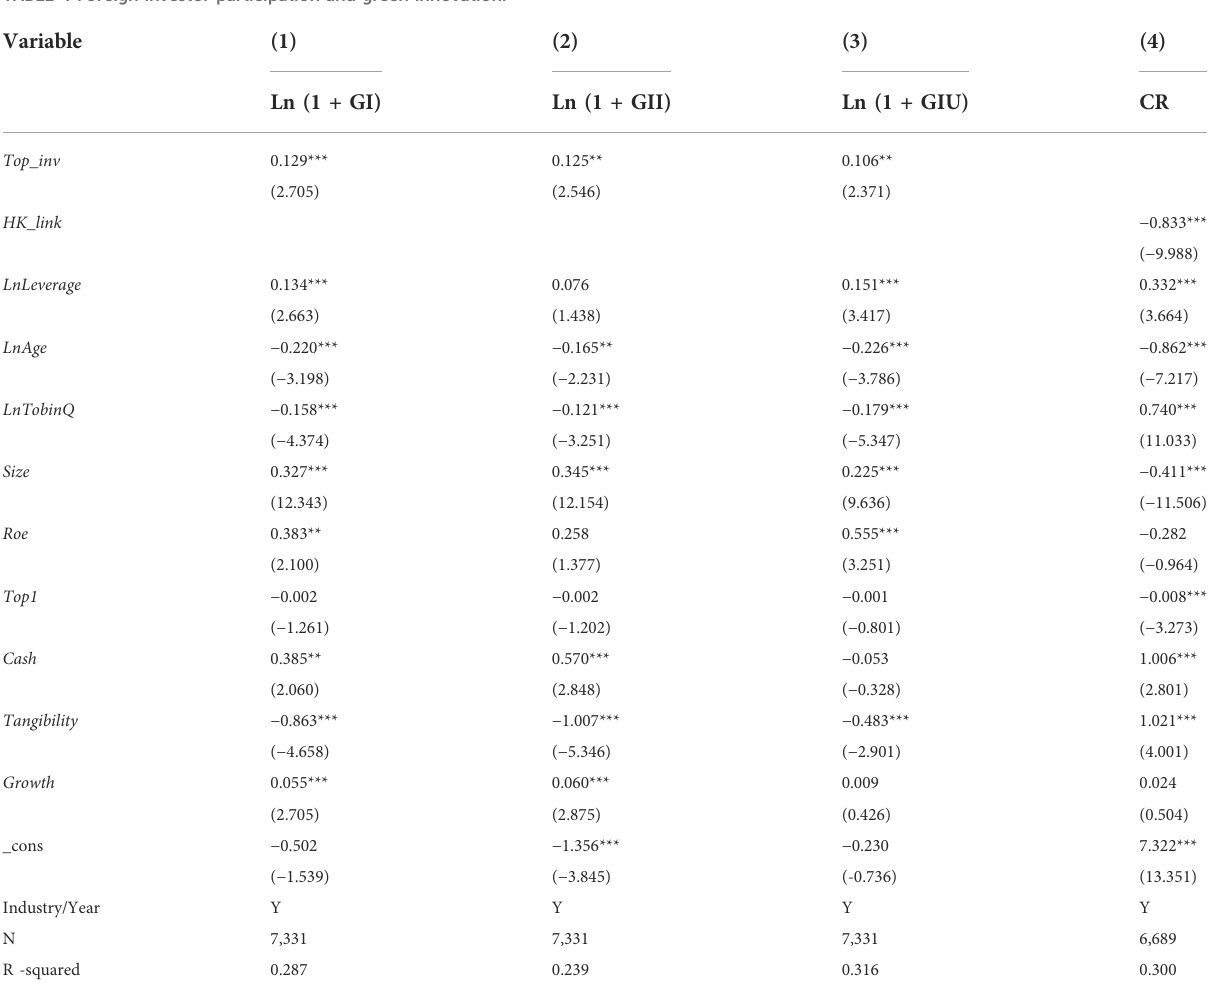
TABLE 4 Foreign investor participation and green innovation.